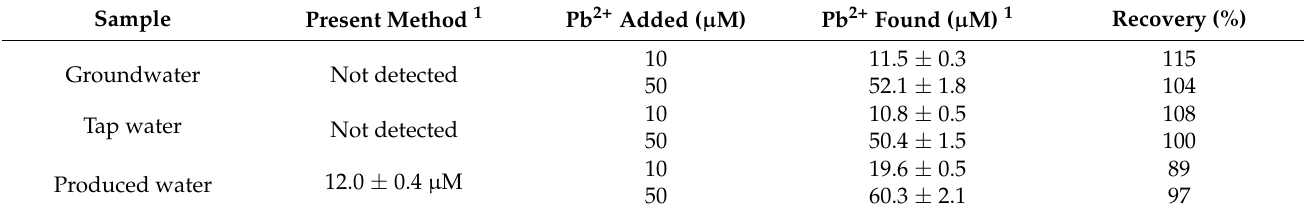
Table 2. Pb(II) content in real water samples, measured with SWASV using the GrRAC-70% composite sensor.